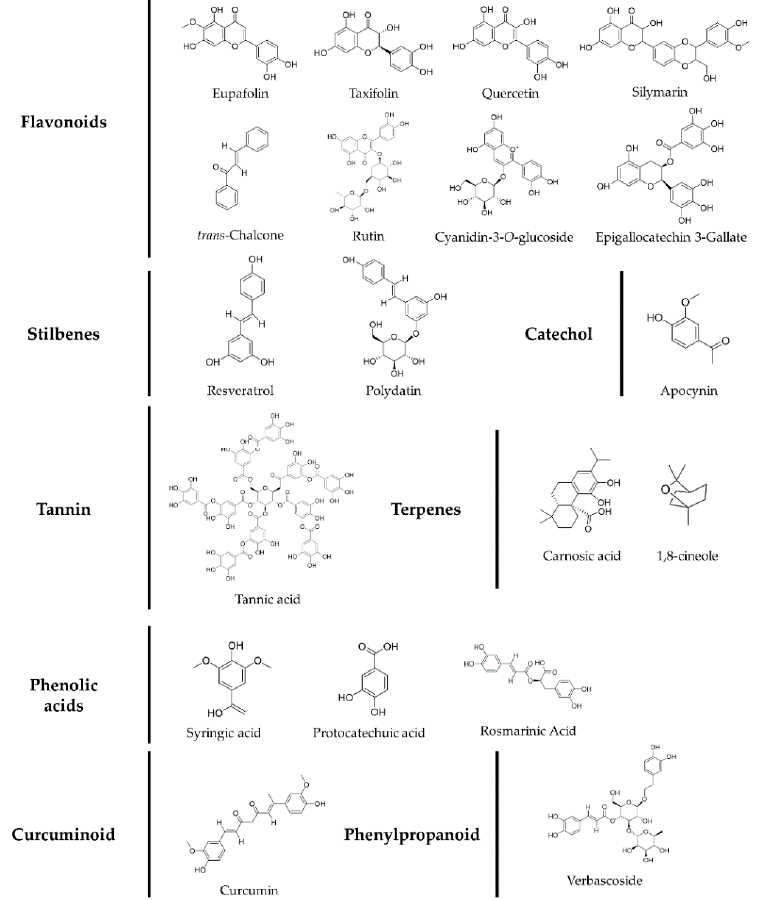
Figure 4. Classification and structures of phytochemicals with regulatory effects on EGFR and NOX activity.